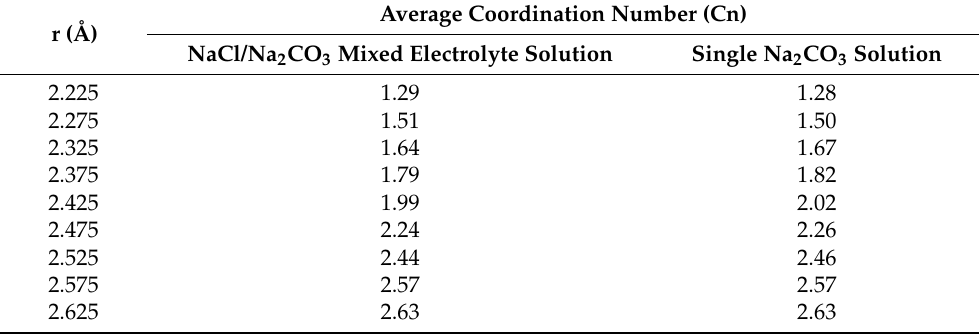
Table 4. Distribution of Na + around CO 32 − in the solution.